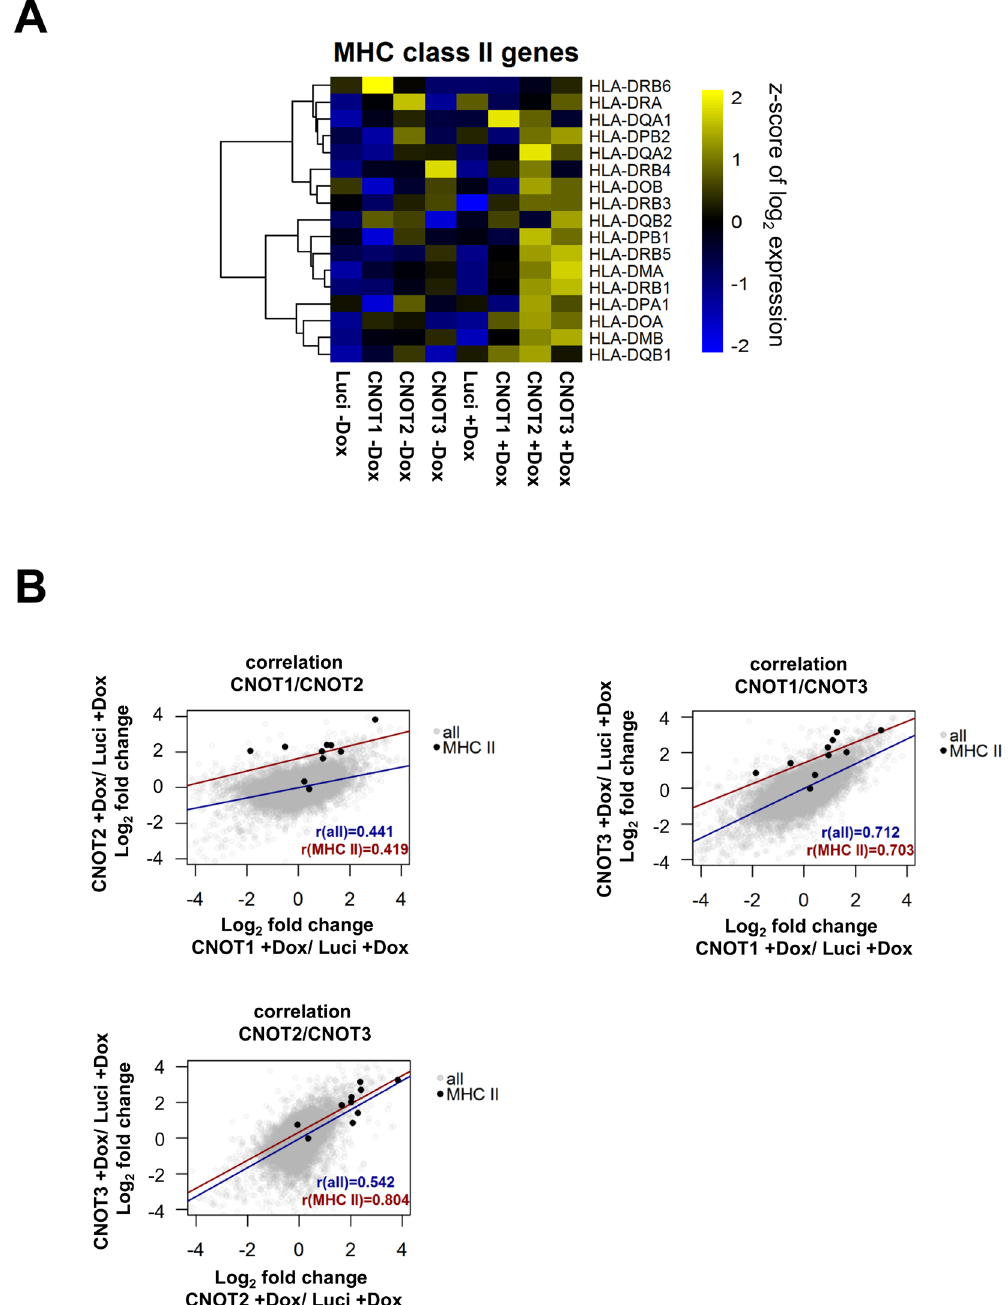
Figure 3. Analysis of CNOT1-3-dependent MHC II gene expression. ( A ) Heat map visualization of MHC II gene expression changes in the different samples as revealed by the microarrays. ( B ) Correlation of the fold changes (in log 2 scale) in the respective CNOT knock-downs versus the control (pIND Luci + Dox). MHC II genes are marked with black dots. The regression line and r coefficient are shown for the MHC II genes (red) and all data points